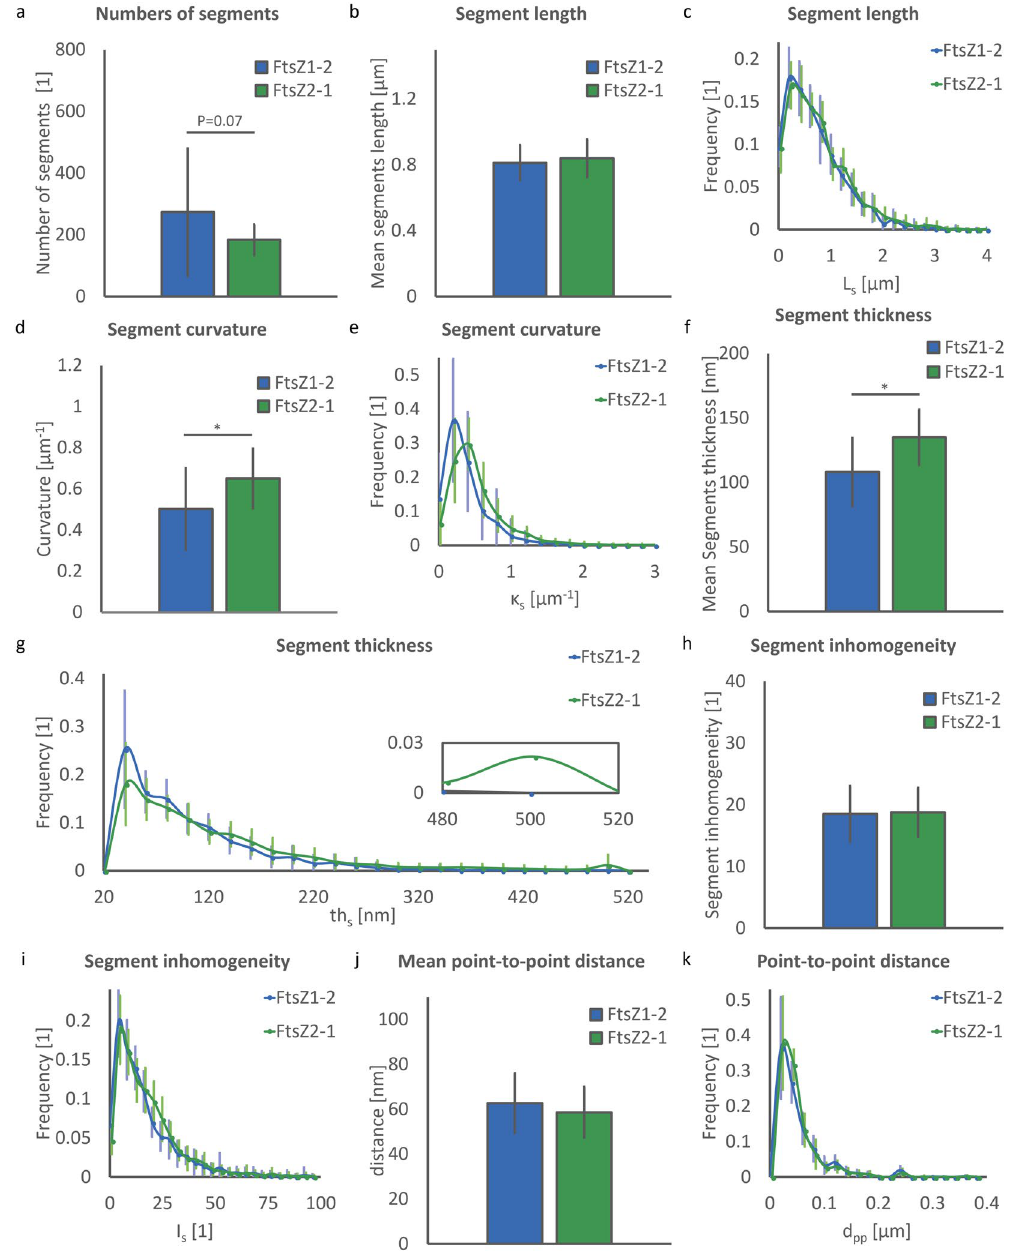
Figure 6. Evaluation of element morphology. ( a ) Number of segments. ( b ) Mean values of segment length. ( c ) Normalised distribution of segment length. ( d ) Mean values of segment curvature per network. ( e ) Normalised distribution of segment curvature in FtsZ1-2 and FtsZ2-1 isoforms. ( f ) Mean values of segment thickness. ( g ) Normalised distribution of segment thickness. Inset shows segments above 480 nm thickness. ( h ) Segment inhomogeneity. ( i ) Normalised distribution of segment inhomogeneity. ( j ) Mean values of point-to-point distance per network. ( k ) Normalised distribution of point-to-point distance. ( a – k ) A total of 40 networks (20 networks for each isoform) were used for each statistical analysis. Each network corresponds to a distinct chloroplast. For each plot FtsZ1-2 and FtsZ2-1 are represented in blue and green, respectively and data is shown as mean ± standard deviation. In the bar plots * indicates significant difference between isoforms. ( a ) One value per network. ( b , d , f , h ) mean of all segments per network. ( c , e , g , i , k ) normalised distribution of all segments per network. ( a – k ) 5472 and 3676 segments were analysed for FtsZ1-2 and FtsZ2-1